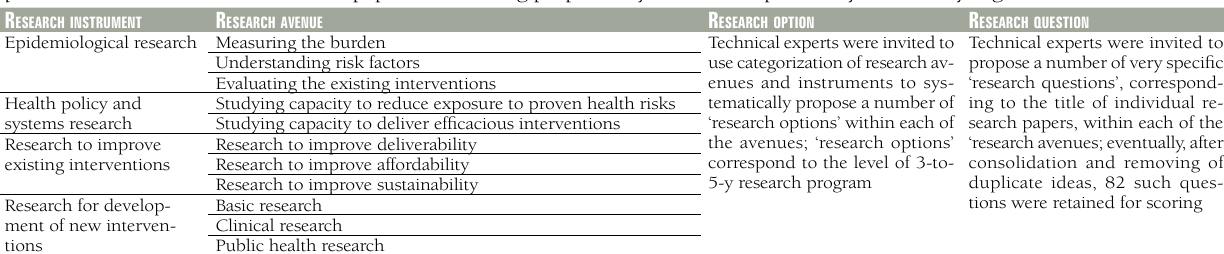
Table 1 CHNRI’s starting framework from which listing of many research options (level of 3-to-5-year research program) and research questions (level of individual research papers) were being proposed by technical experts to systematically organize 82 research